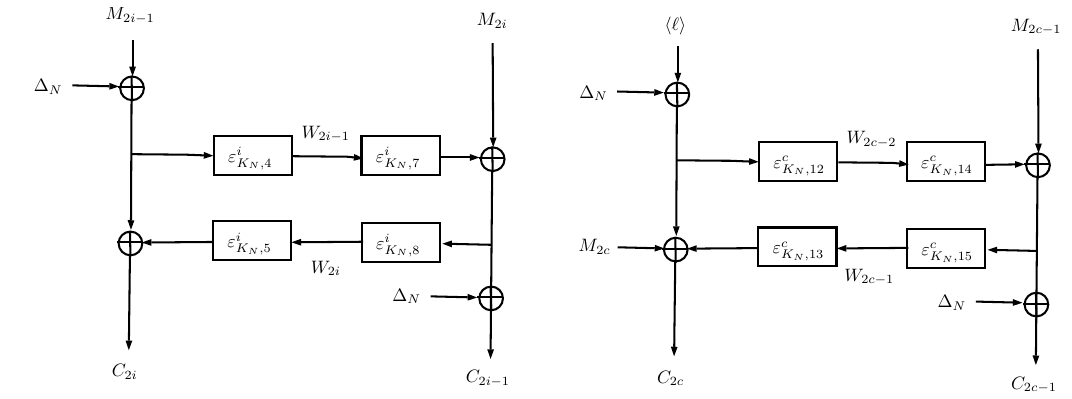
Figure 4. Block diagram of LOTUS mode for encryption.